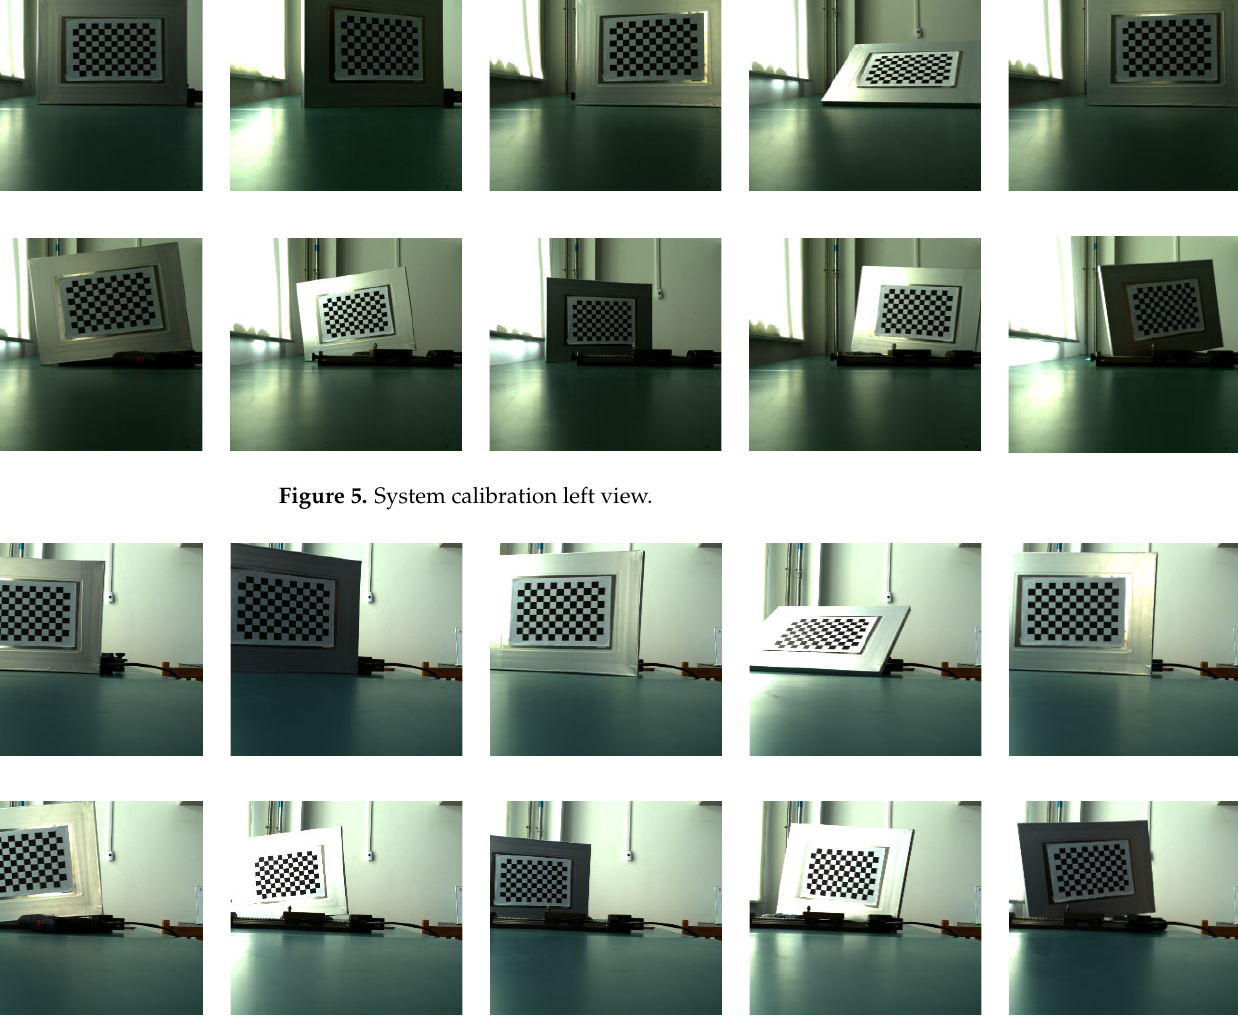
Figure 6. System calibration right view. Table 3. System calibration parameters. Table 3. System calibration